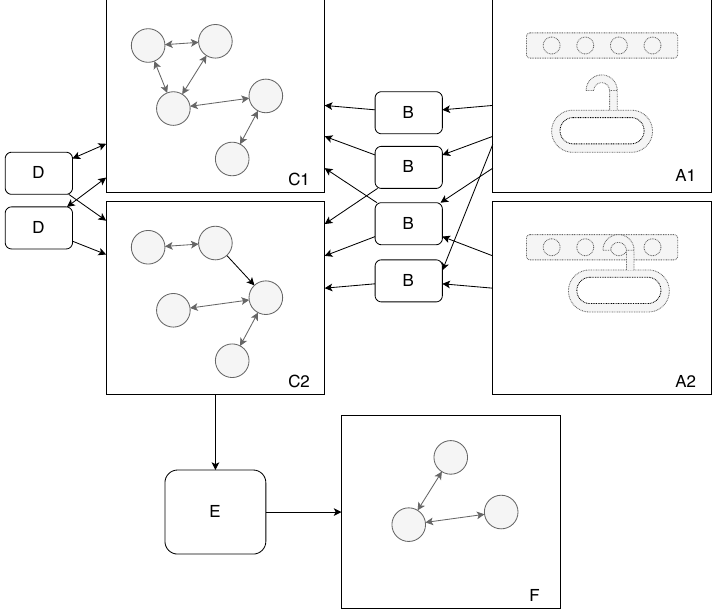
Figure 1. System overview. A1 —point cloud before task execution; A2 —point cloud after task execution; B —feature detection routines; C1 —scene understanding graph before task execution; C2 —scene understanding graph after task execution; D —relation detection routines; E —reasoning module; F —task